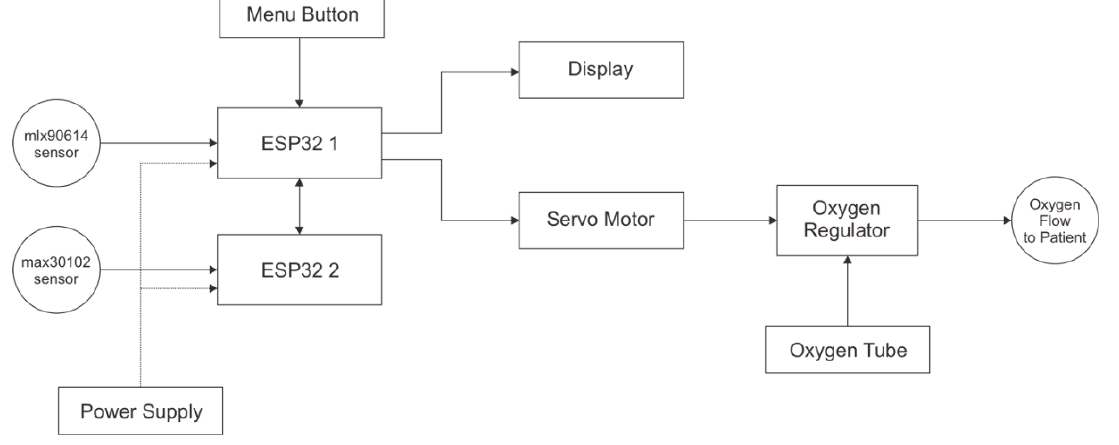
Figure 1 . Proposed